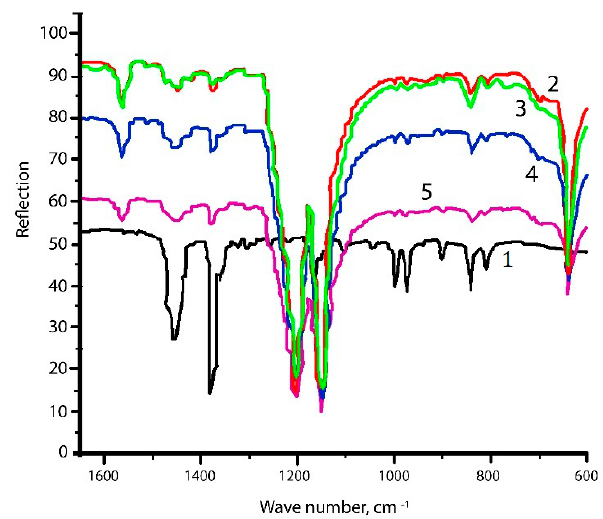
Figure 6. IR-spectra (MATR) of PP films with PTFE coatings doped with magnetite stabilized by sodium stearate and subjected to abrasion a different number of times: 1, without a coating; 2, with a coating; 3, with a coating subjected to abrasion 10 times; 4, with a coating subjected to abrasion 50 times; 5, with a coating subjected to abrasion 500 times.